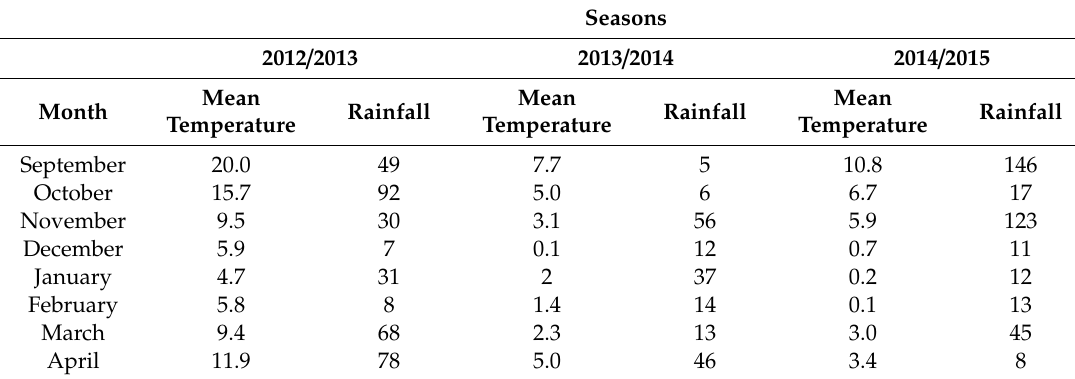
Table 1. Monthly mean temperature ( ◦ C) and cumulative rainfall (mm) from September to April) during three observation